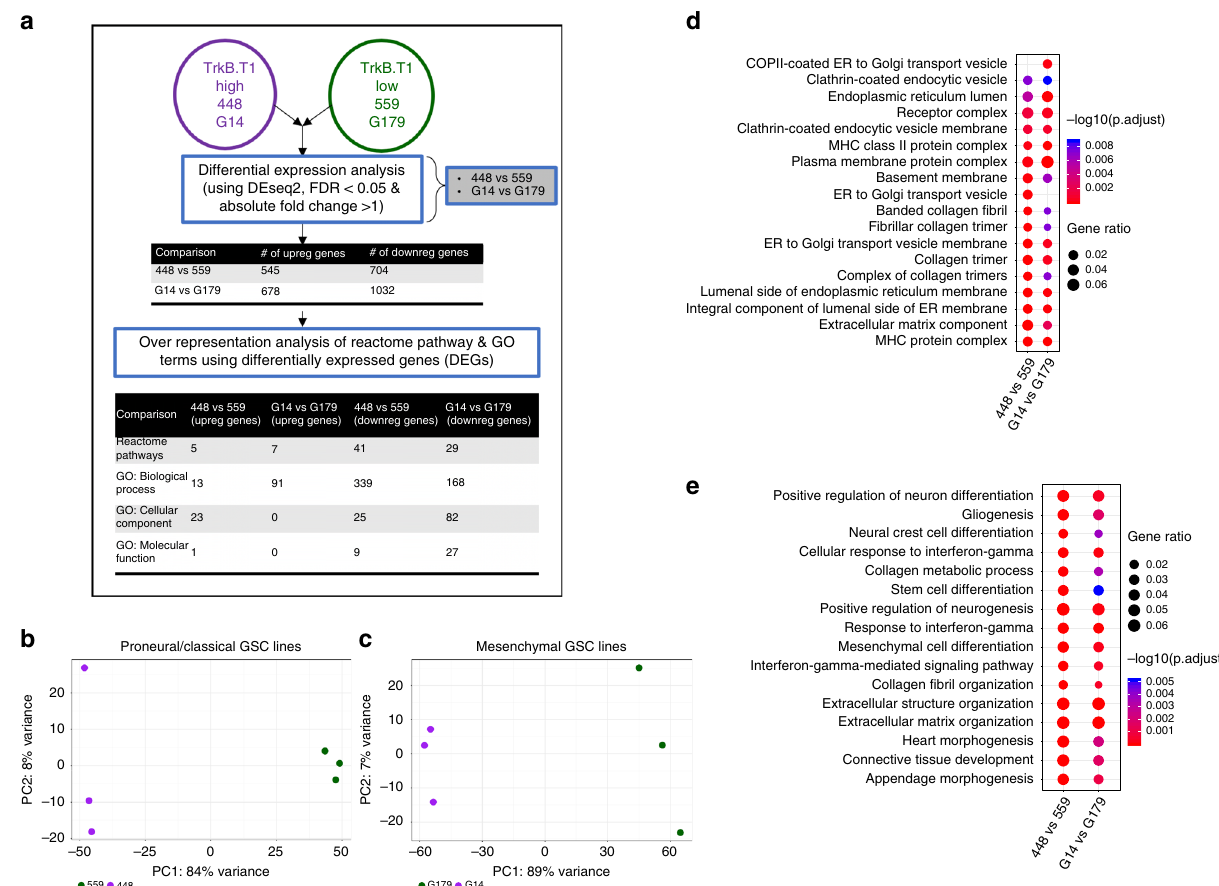
Fig. 6 DE analysis reveals distinct gene expression patterns between TrkB.T1 High vs TrkB.T1 Low GSC lines. a Schematic for differential gene expression analysis between TrkB.T1 High (classical/proneural replicates 448 1 – 3; classical/mesenchymal G14 replicates 1 – 3) and TrkB.T1 Low (classical/proneural replicates 559 replicates 1 – 3; classical/mesenchymal G179 replicates 1 – 3). b PCA plots show distinct clusters for the TrkB.T1 High GSC line (488) compared with the TrkB.T1 Low GSC (559) line in the classical/proneural lines and distinct and ( c ) for the TrkB.T1 High GSC Line (G14) compared with the TrkB.T1 Low GSC line (559). GO analysis revealed distinct genesets downregulated in the cellular compartment ( d ) and distinct genesets downregulated in biological processes ( e ) in the TrkB.T1 High (448 and G14) line compared with the TrkB.T1 Low (559 and G179) lines. TrkB.T1 Low lines (559 and G179) shown in green and TrkB.T1 High lines (448 and G14) shown in